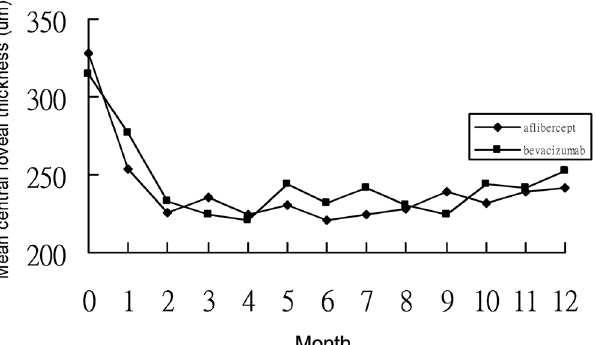
Figure 2. Changes of central foveal thickness from baseline to month 12 in patients with myopic choroidal neovascularization treated by intravitreal aflibercept or